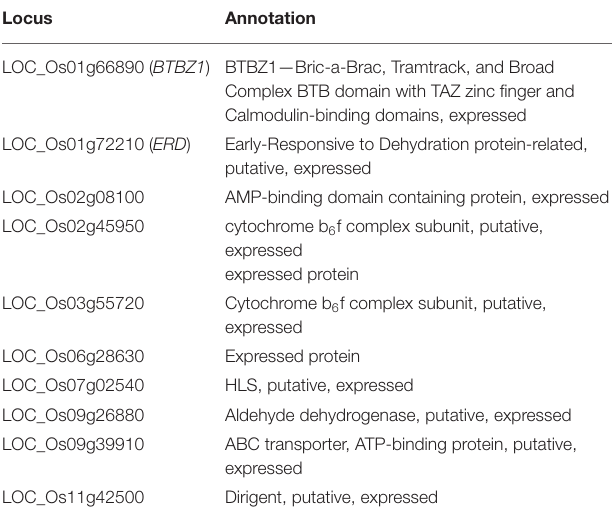
TABLE 3 | Salt-tolerant genes consistently predicted by GCN, CC, and WGCN.